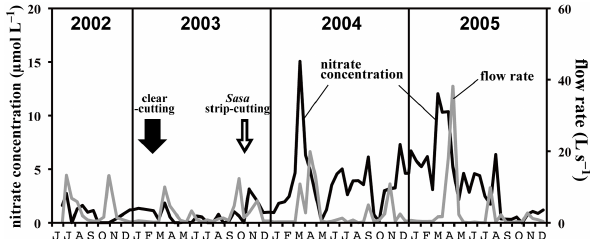
Figure 2. Temporal variations in nitrate concentrations in stream water (black line), together with those of flow rate of the stream water (grey line). Solid and open arrows denote the period of clear- cutting of trees and strip-cutting of Sasa , respectively. The temporal variations in nitrate concentration from June 2002 to the end of 2004 were previously presented by Fukuzawa et al.